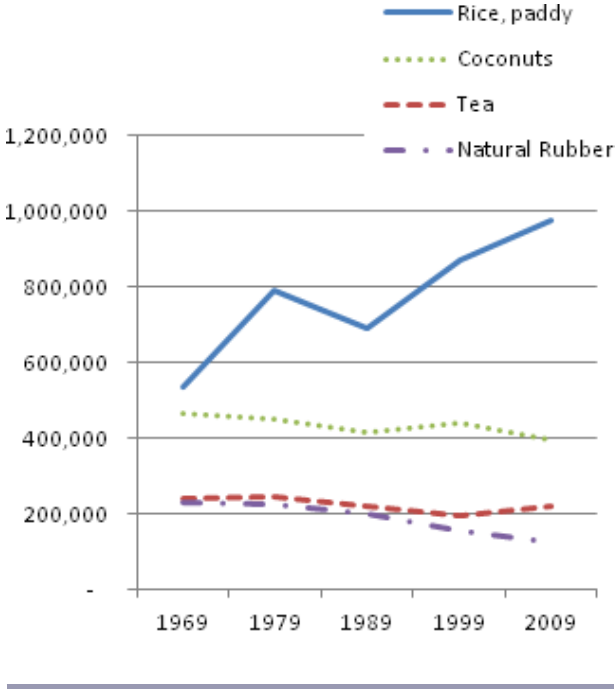
Fig. 2 . Harvest area for major agricultural commodities of